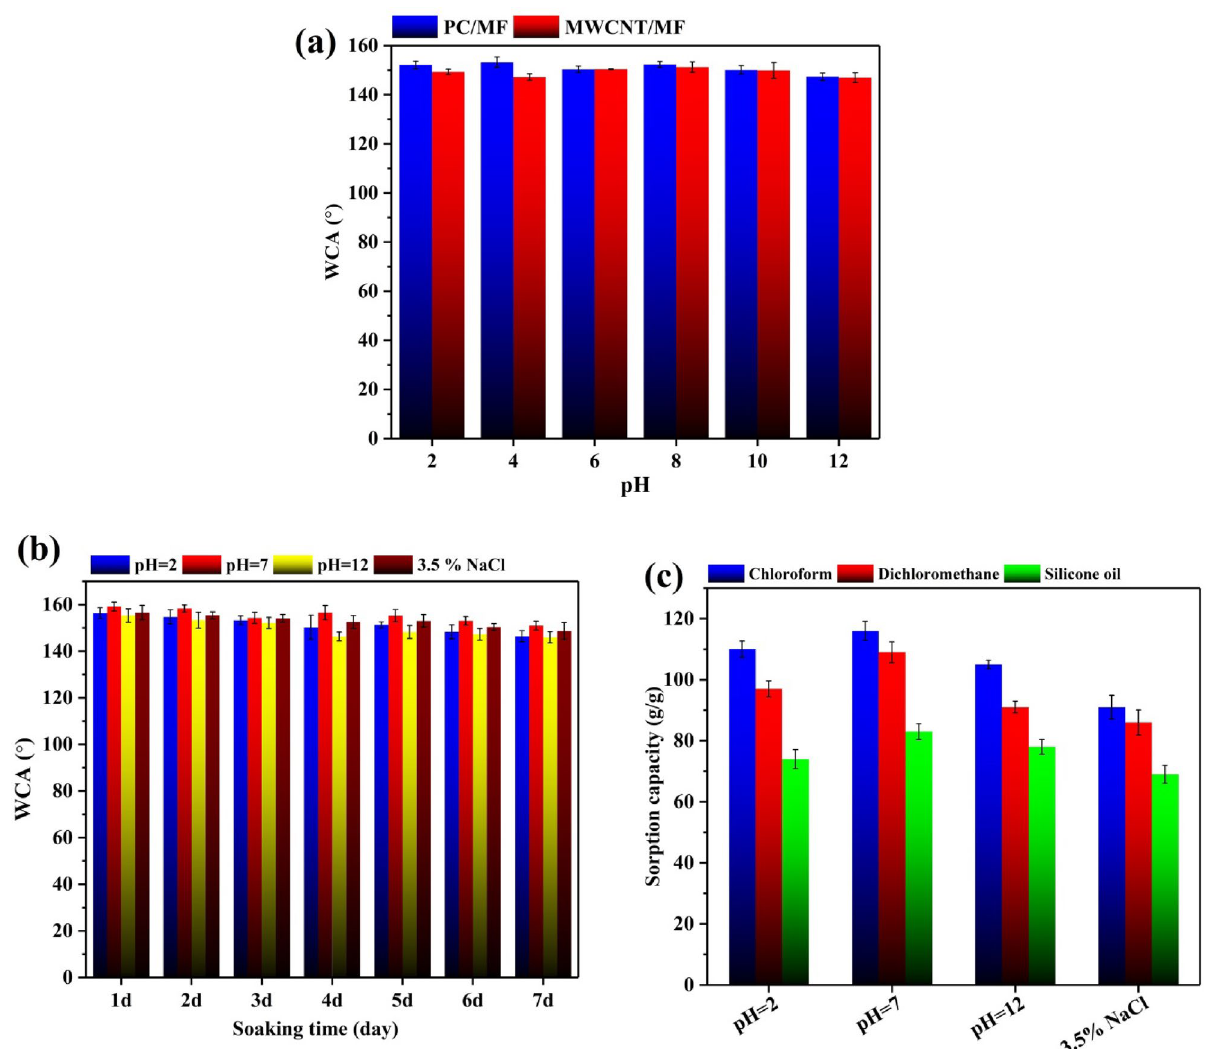
Figure 10. ( a ) Contact angle of droplets with different pH on PC/MF and MWCNT/MF, ( b ) WCA and ( c ) sorption capacity of MWCNT/MF in acidic, alkaline, and saline